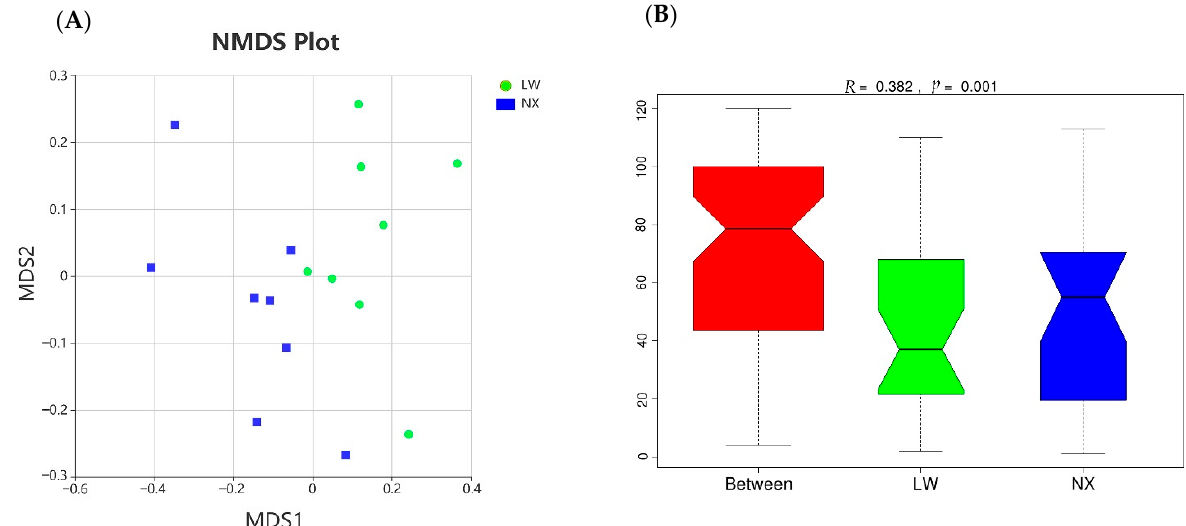
Figure 3. ( A ) Nonmetric multidimensional scaling (NMDS) plots of β diversity based on the relative abundance of OTUs in samples. ( B ) Anosim analysis of β diversity. LW, Large White; NX, Ningxiang.